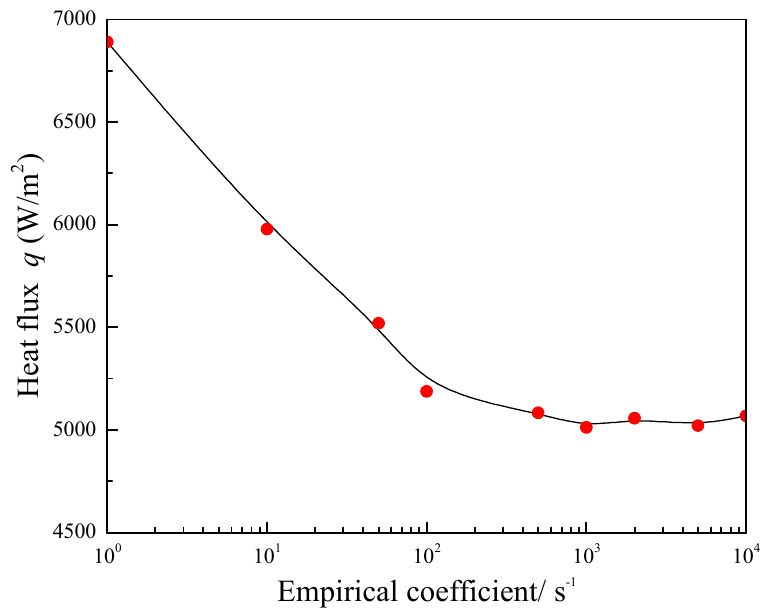
Figure 3. The calculated heat flux with different r i values (Adapted from Ref. [2]).